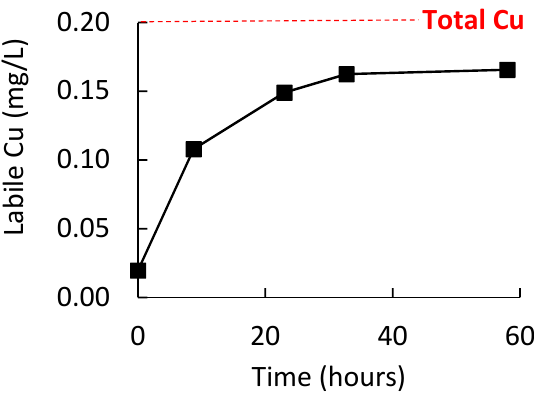
Figure 3. Labile Cu concentration during the stirring white wine (750 mL) at room temperature and under ≈ 1.5 L of air ullage. Error bars are the standard deviation but are smaller than the data symbols. Table 1. Total and labile Cu concentrations in pretreated wines and the correlation of the standard additions curve.